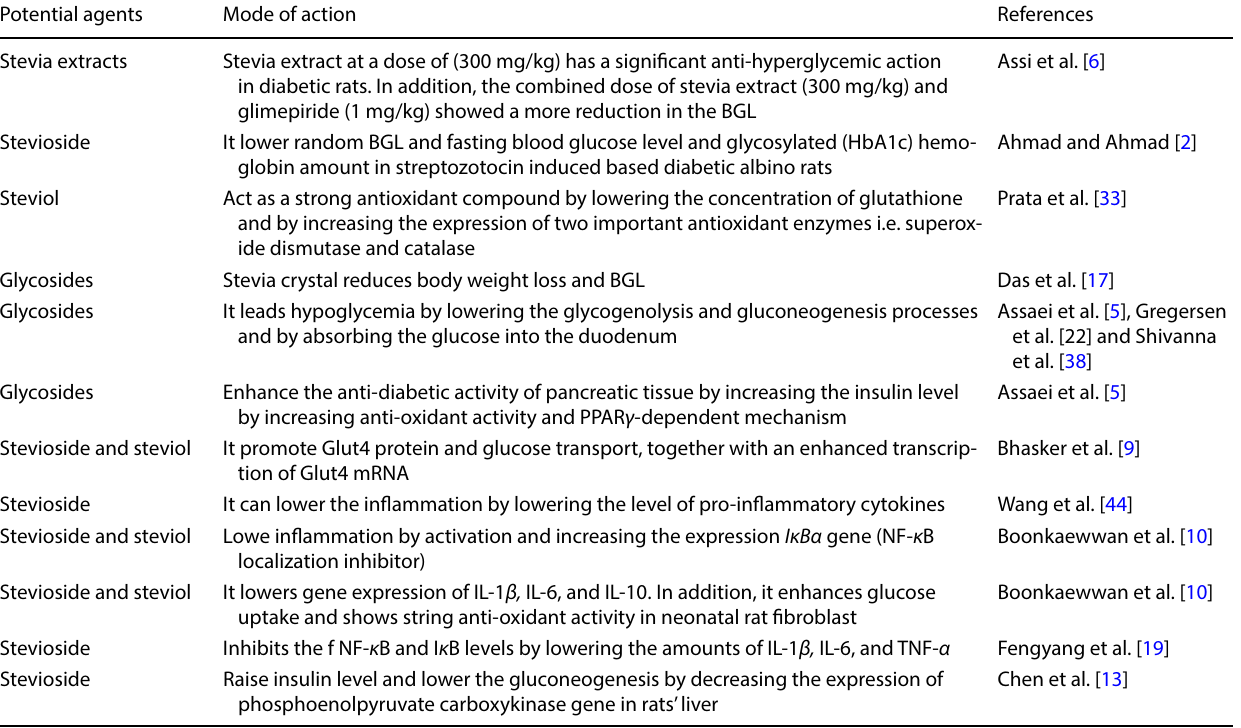
Table 2 The Potential bioactive metabolites of Stevia and their mode of actions against diabetic disease Potential agents Mode of action